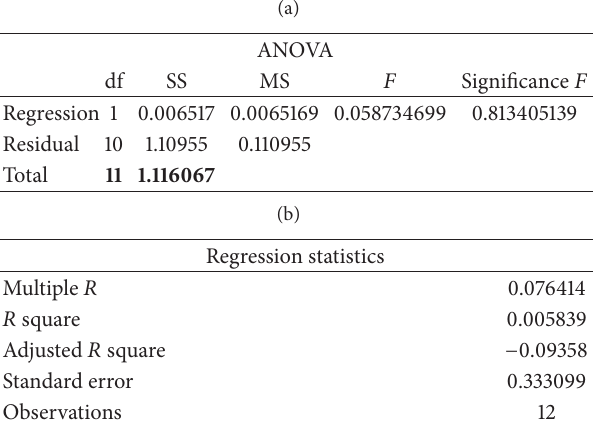
Table 4: Results of the multiple regression analysis are